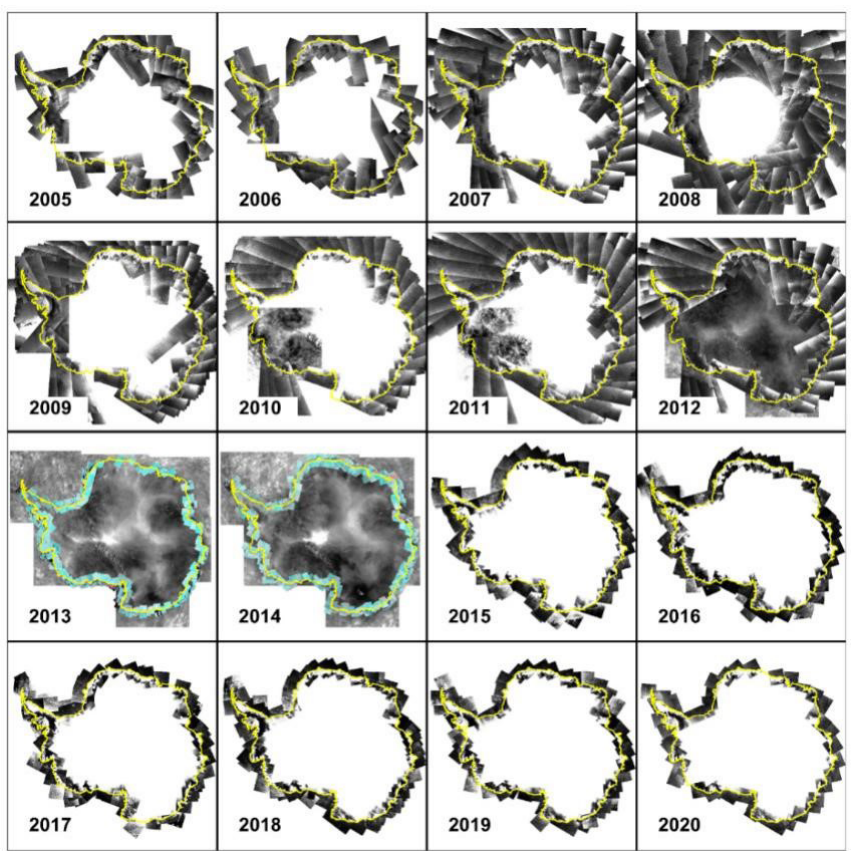
Figure 2. Schematic showing the results of satellite imagery preprocessing. We mainly used Envisat ASAR images for 2005–2012, Landsat 8 OLI images for 2013/2014, MODIS images for 2012–2014, and Sentinel-1 SAR images for